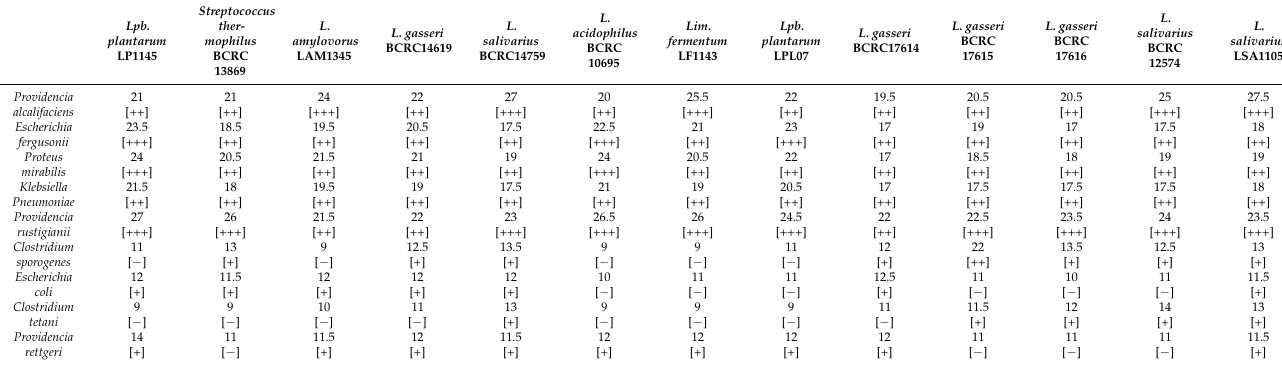
Table 5. Inhibition of TMA-producing bacteria by lactic acid